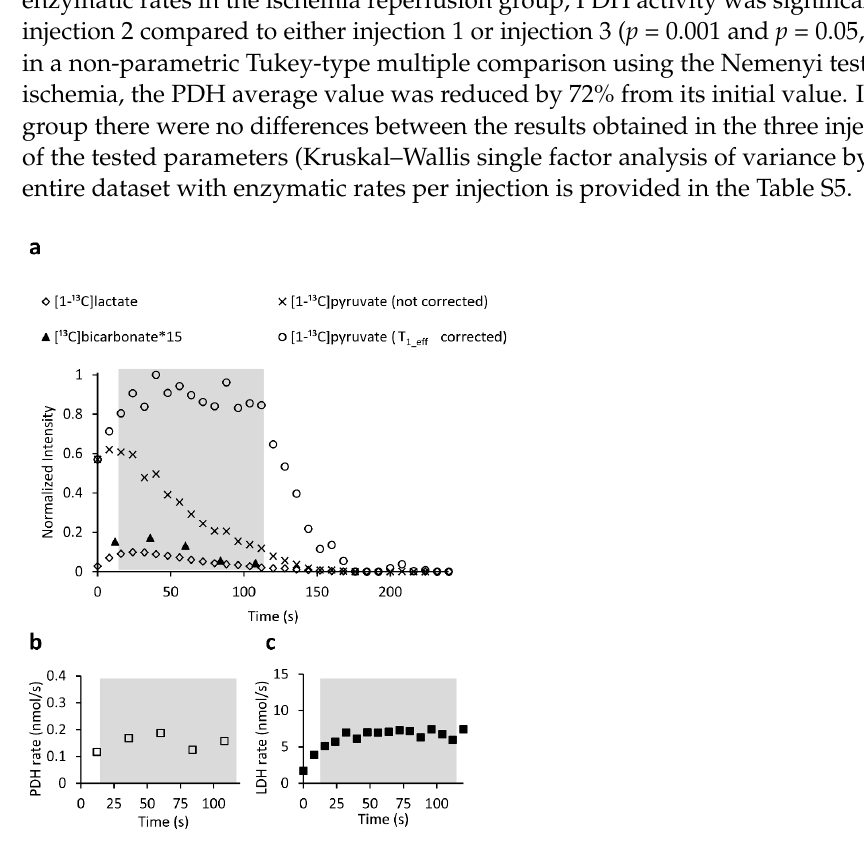
Figure 4. Signal time courses and selection of time points for enzymatic rate determination. ( a ) A typical time course of the hyperpolarized signal intensities following injection of hyperpolarized [1- pyruvate to brain slices. The measured [1- 13 C]pyruvate signal is shown with “x” markers and the T 1_eff corrected signal is marked with open circles. The T 1_eff corrected signal was used to determine the time frame at which the concentration of [1- 13 C]pyruvate in the sensitive region of the NMR probe was constant and maximal (shaded area). Only measurements within this time frame were used for the enzymatic rate determination (Methods). For [ 13 C]bicarbonate, the averaged spectrum of three consecutive spectra was used for each point. ( b ) The PDH rate determined from the data presented in a. Only points in the shaded area were used for rate calculation. ( c ) The LDH rate determined from the data presented in a. Only points in the shaded area were used for rate